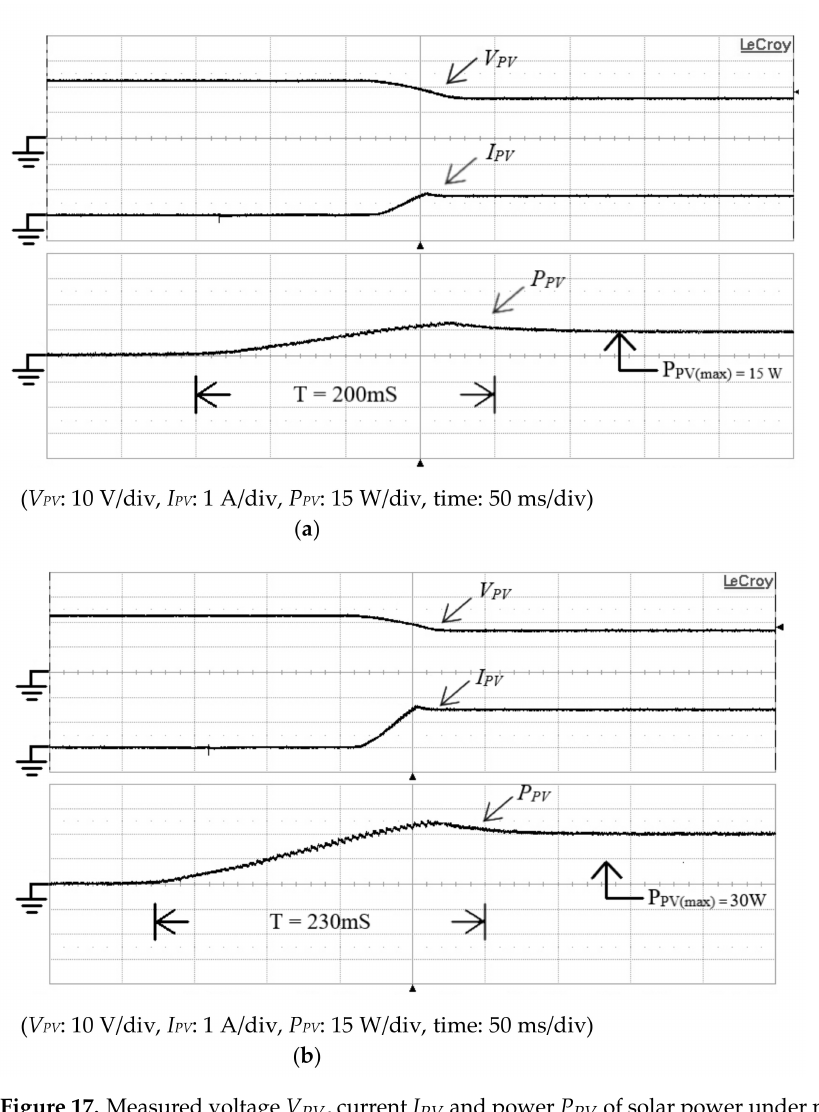
Figure 17. Measured voltage V PV , current I PV and power P PV of solar power under maximum power